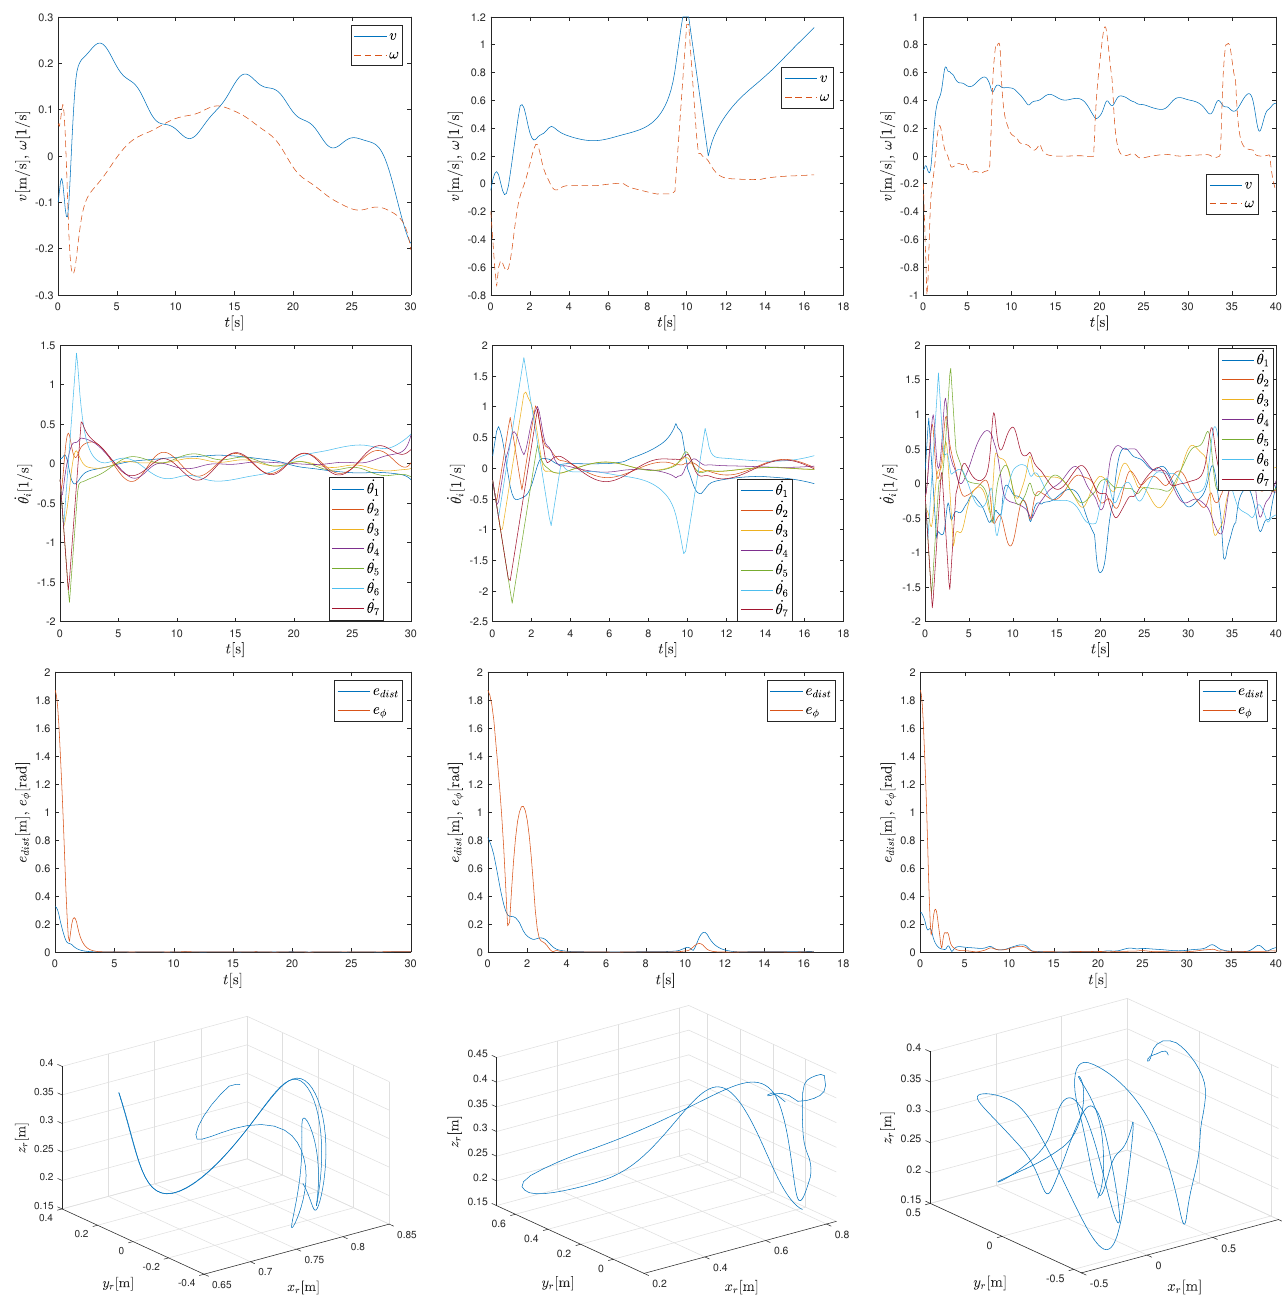
Figure 6. Mobile base velocities (first row), arm joint velocities (second row), tracking distance error and orientation error norm (third row), and relative position of the end effector with respect to the mobile base (fourth row) for the scenarios in Figure